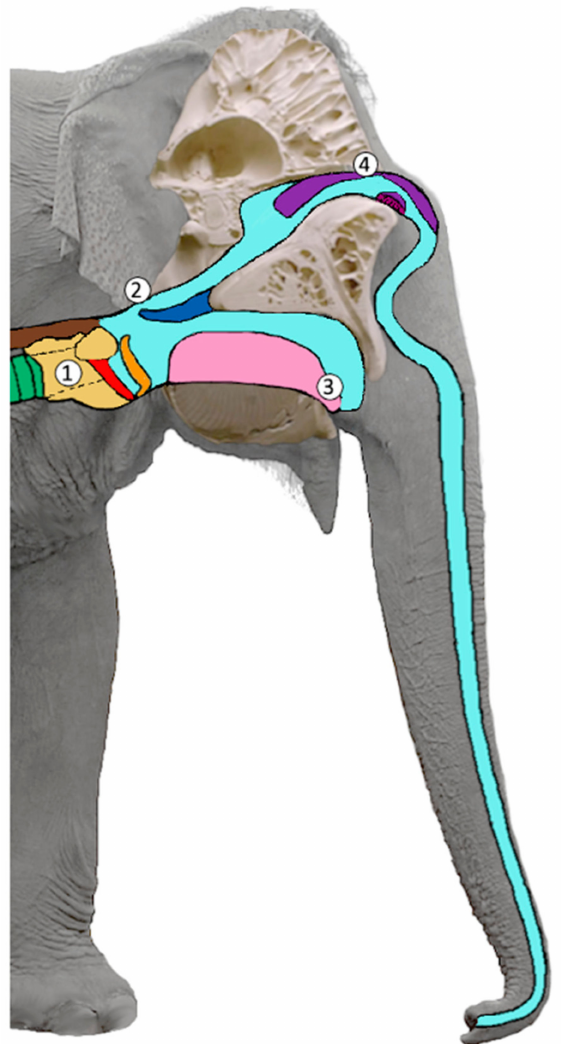
Figure 1. Schematic figure of the vocal tract in sagittal view: (1) larynx (yellow), vocal folds (red), epiglottis (orange), trachea (green), esophagus (brown); (2) velum (dark blue); (3) tongue (pink); (4) nasal cartilages (violet). In this figure, the epiglottis is slightly open unifying the oral and nasal vocal tract. When the (2) velum (dark blue) is lowered and touches the epiglottis (orange) the oral vocal tract can be closed, and the nasal vocal tract opened for purely nasal sound emission (adapted from